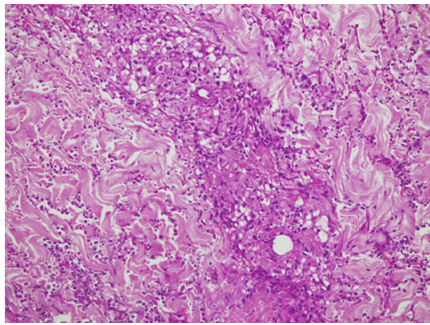
Figure 3: CT abdomen with contrast: multiple hypoattenuating lesions in the liver.